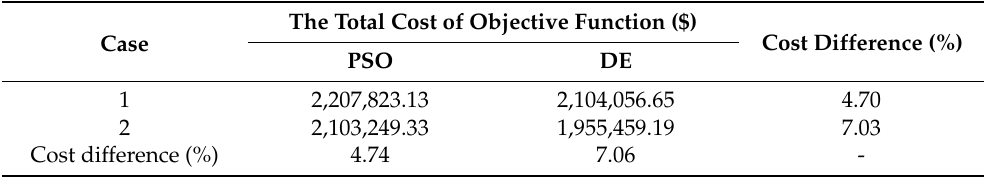
Table 6. Comparison of the total cost of the objective function for case 1 and case 2 after solving the optimal scheduling of ESS by the DE and PSO